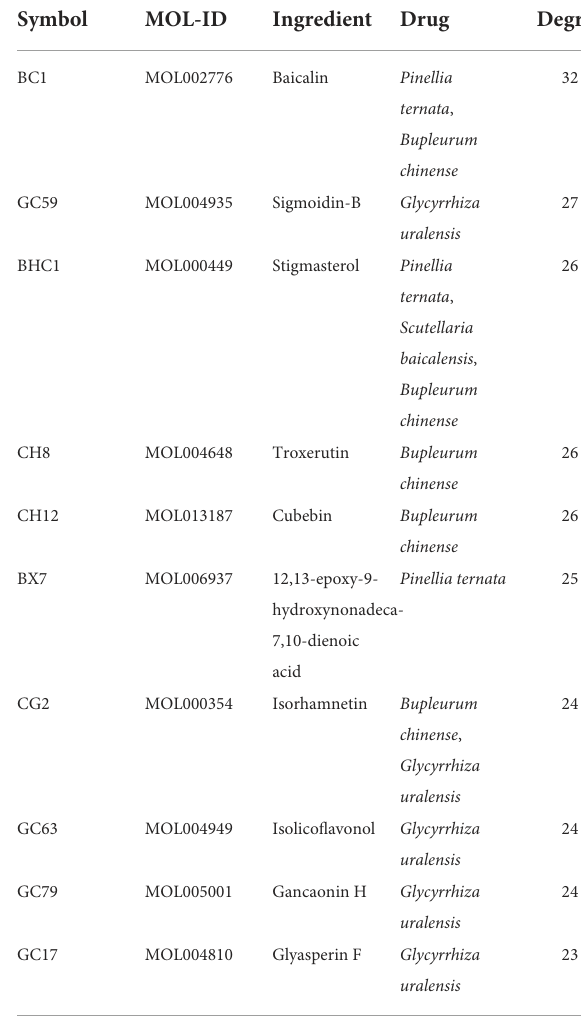
TABLE 7 Information of 10 core genes after protein–protein network analysis.